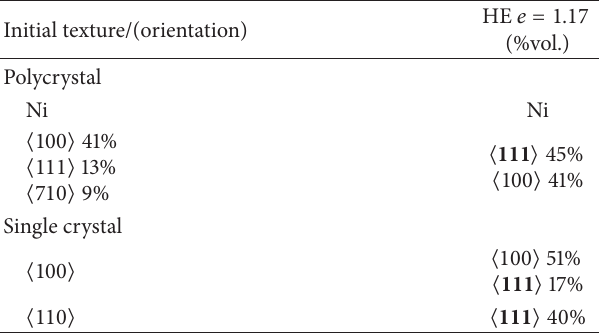
Figure 3: Microstructure after HE with 𝜀 = 1.2 of initial Ni single crystal ⟨110⟩ (a), ⟨100⟩ (b), and polycrystal (c).